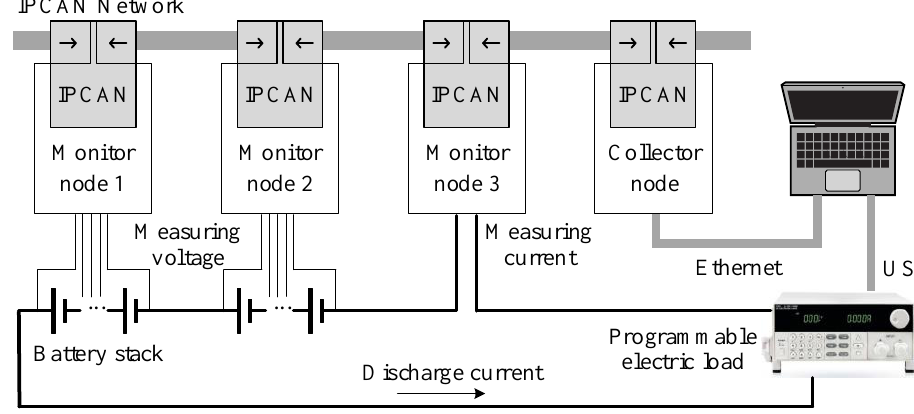
Figure 4. The block diagram of the battery test system.